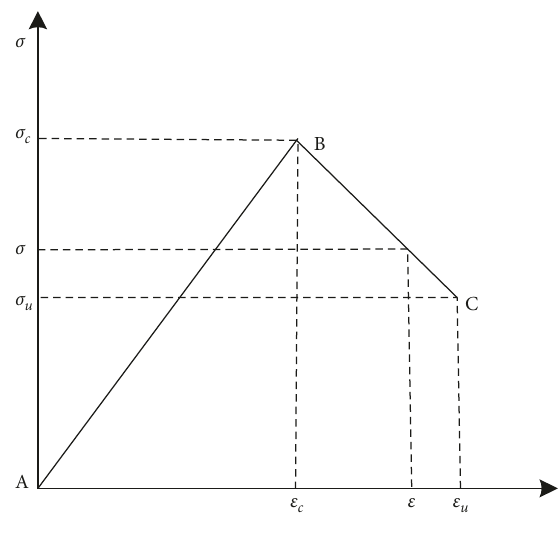
Figure 1: Bilinear damage